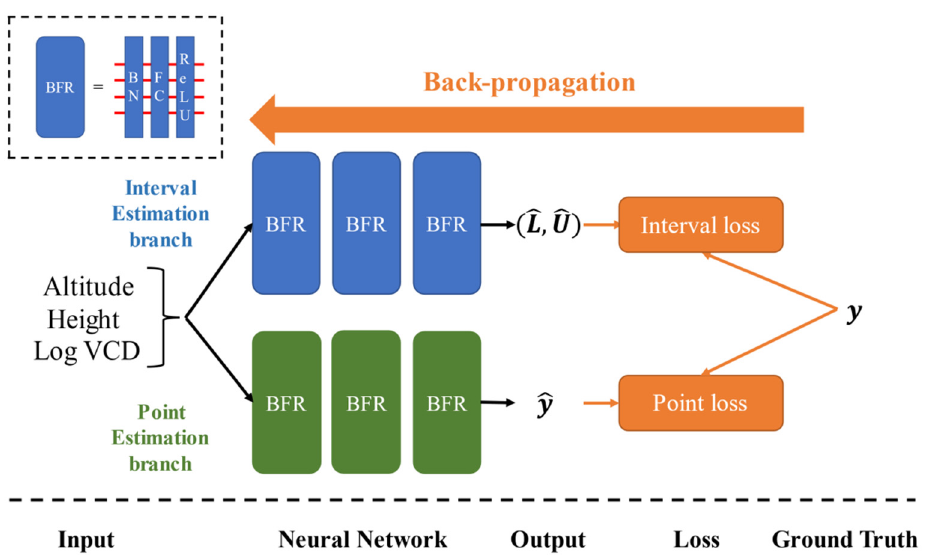
Figure 5. Illustration of two separate neural networks for point and interval estimations respectively. Each network has three BFR blocks (with ReLU in the last block disabled).